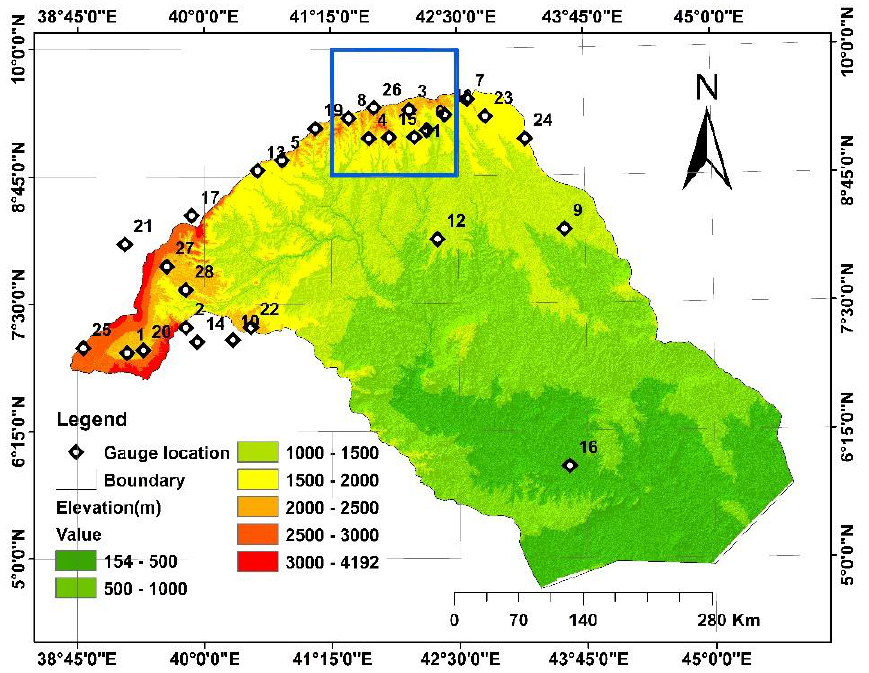
Figure 1. Study area description with rain gauge station distribution and topography elevation of Wabi Shebelle River Basin, Ethiopia.